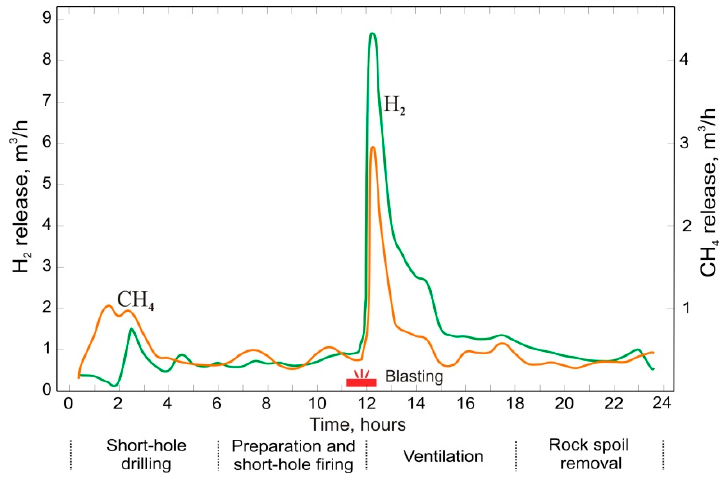
Figure 13. Trend of the absolute gas content (AGC) variation for dead ends during mining operations at the Karnasurt loparite mine (modified from [18]).